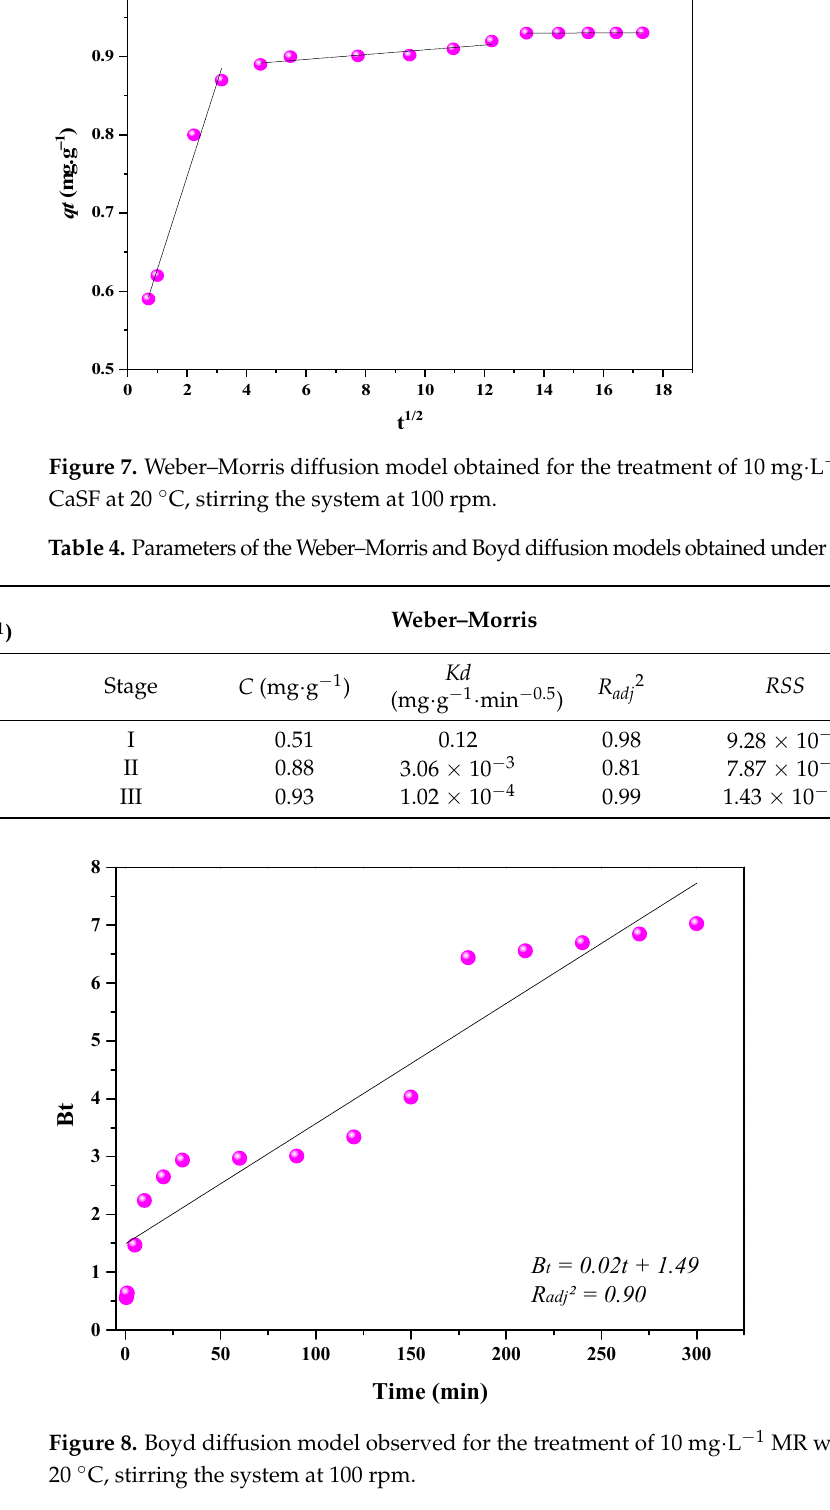
Figure 9. Proposed adsorption mechanism. 3.5. Adsorption Equilibrium Adjusting the experimental data with the theoretical adsorption isotherm models makes it possible to estimate q max for the CaSF dosage used, in addition to the type of adsorption taking place in the process (physical adsorption, chemisorption or both). Figure 10 shows the experimental data with the theoretical models at three different temperatures. The adsorption capacity of CaSF is extremely sensitive to temperature under all the dye concentrations studied. A temperature of 20 °C shows an increasing linear behavior with increasing MR concentrations, and does not reach a saturation stage (equilibrium). At 25 °C and 30 °C, however, saturation is reached for the last three tested concentrations, along with a sudden drop in CaSF adsorption capacity. This type of behavior can be attributed to the combination of the following factors: an exothermic MR adsorption process, pH range and CaSF´s Krafft temperature.